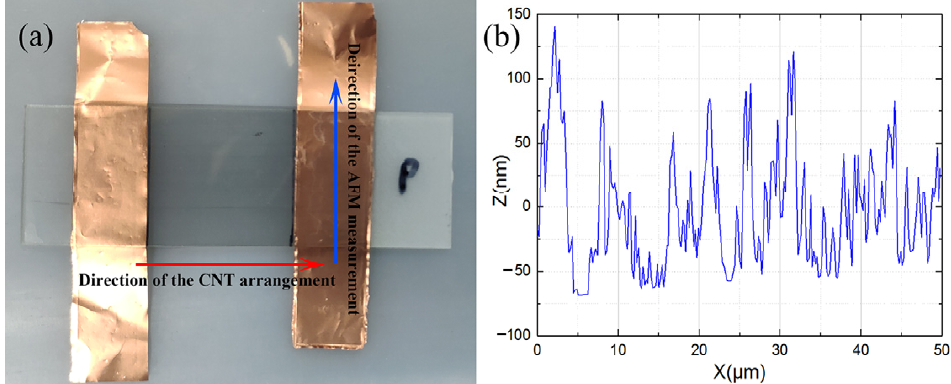
Figure 2. ( a ) The prepared single-layer CNT film without being densified; ( b ) Measured AFM result of the CNT film.